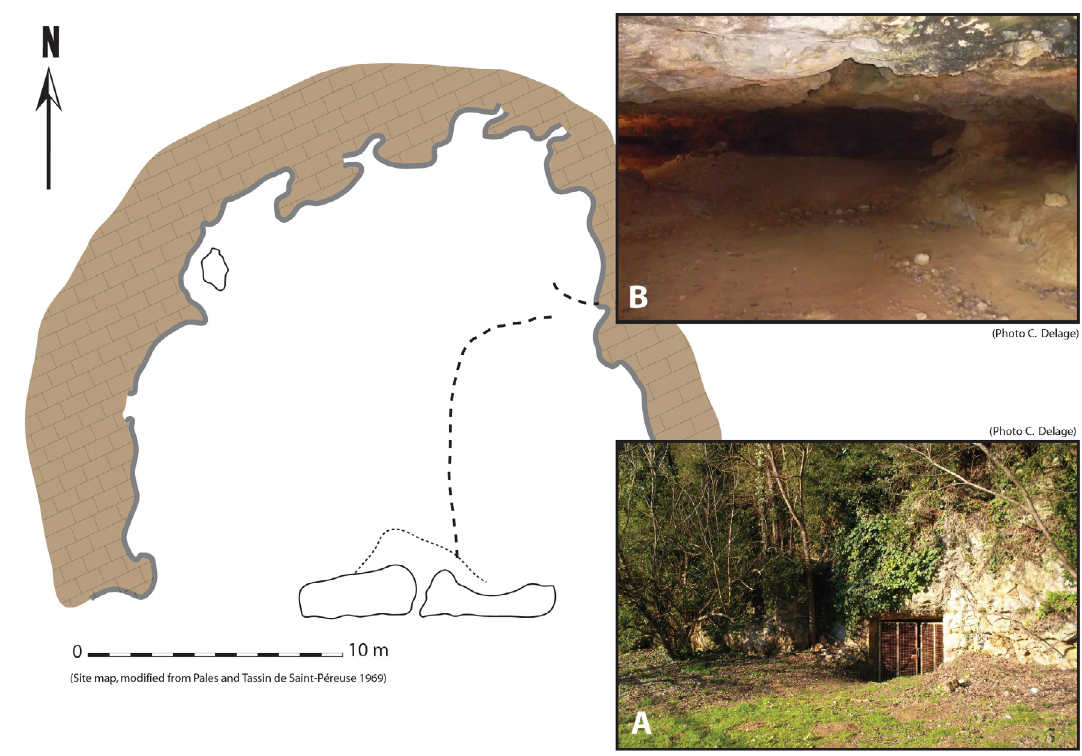
Figure 2. Site map with a view of La Marche from the terrace in front (A) and the inside of the cavity